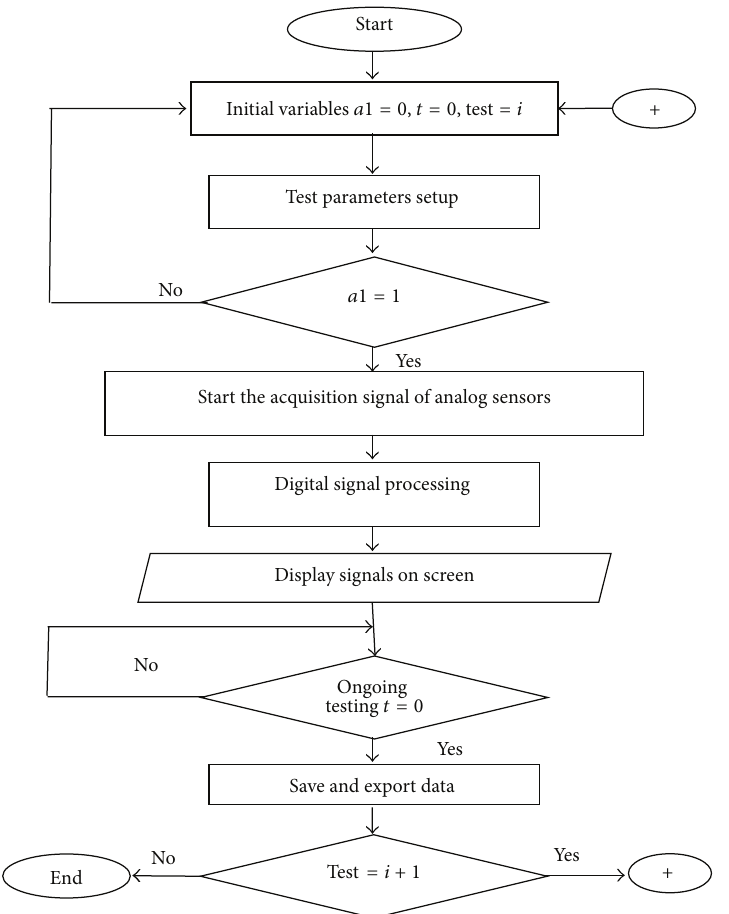
Figure 16: Operation flow scheme of